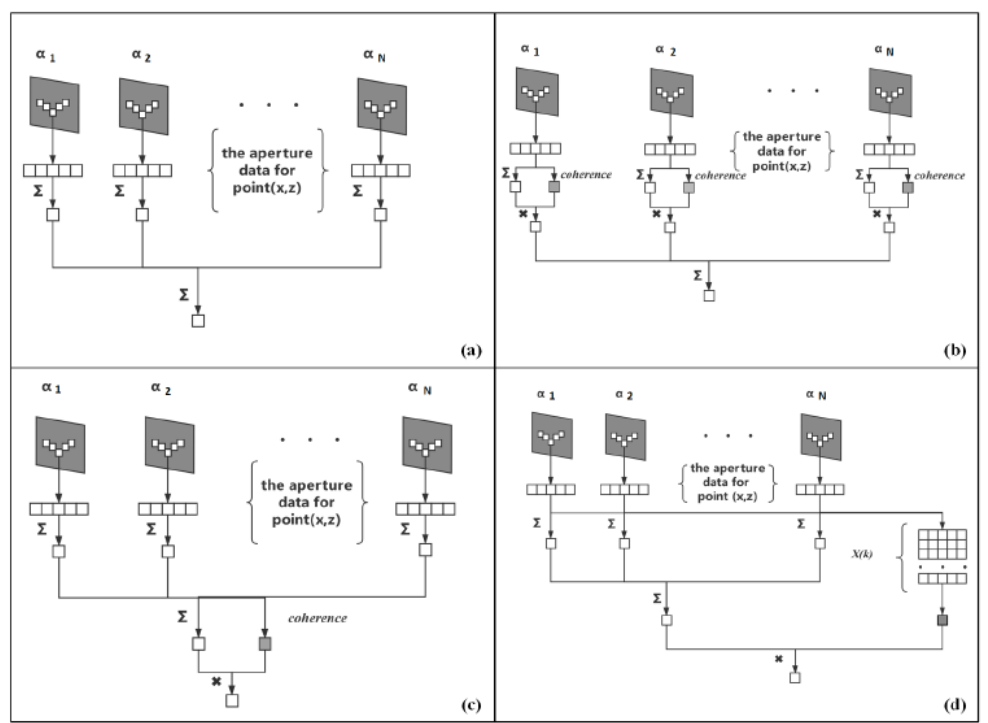
Figure 2. Framework schematic diagrams of CF-based beamformer frameworks. ( a ) DAS, ( b ) the spatial SCF method, ( c ) the angular SCF method, ( d ) the united SCF method. The symbol ∑ represents